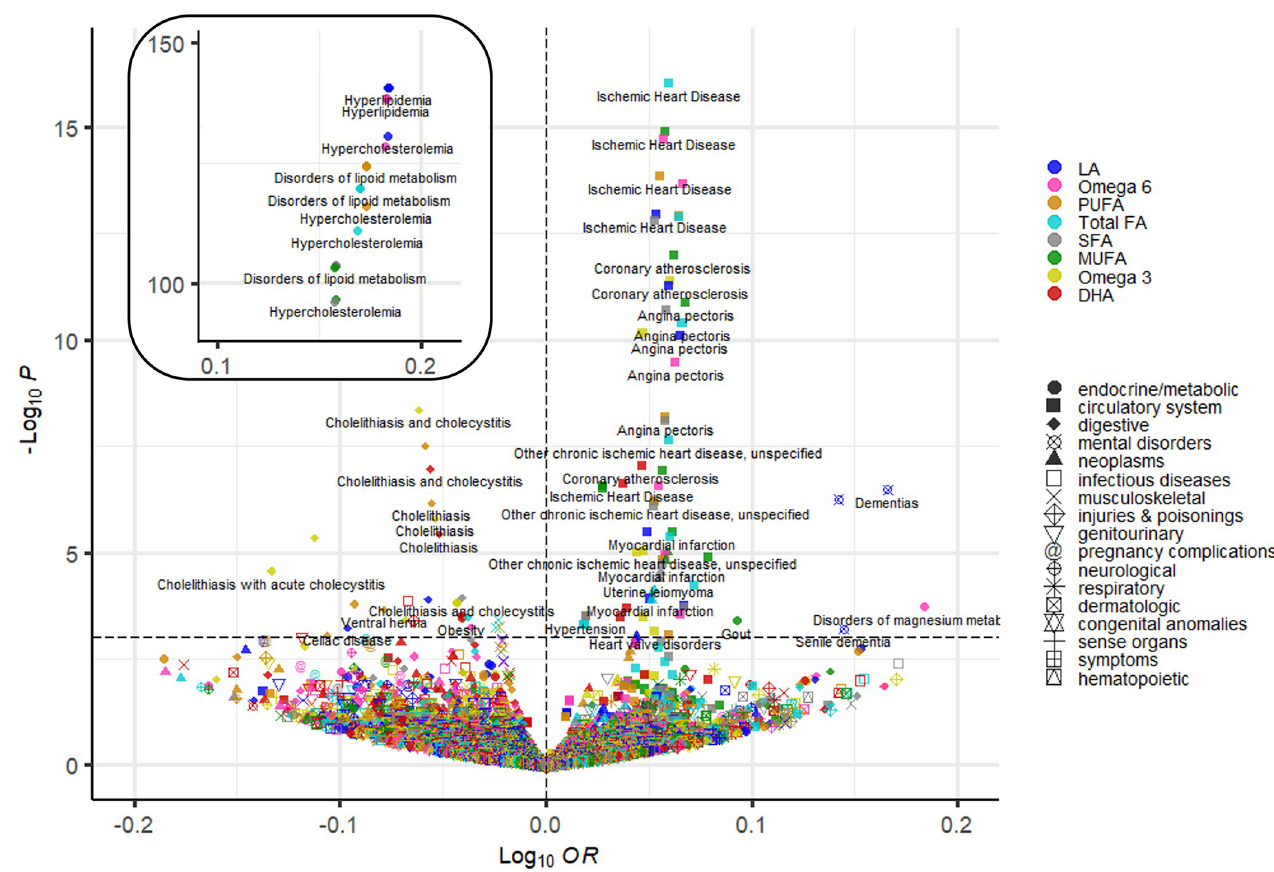
Fig 3. PheWAS results for the associations between 8 weighted GRS of different fatty acids and 845 clinical outcomes in UKB. log(OR) regression estimates are plotted against − log( P value). The dashed line represents the 5% FDR threshold, which corresponds to P = 9.2 × 10 − 4 . Due to their high P values, associations with disorders of lipid metabolism, hypercholesterolemia, and hyperlipidaemia can be seen in the top left box. DHA, docosahexaenoic acid; FDR, false discovery rate; GRS, genetic risk score; LA, linoleic acid; MUFA, monounsaturated fatty acid; PheWAS, phenome-wide association study; PUFA, polyunsaturated fatty acid; SFA, saturated fatty acid; total FA, total fatty acid; UKB, UK Biobank.